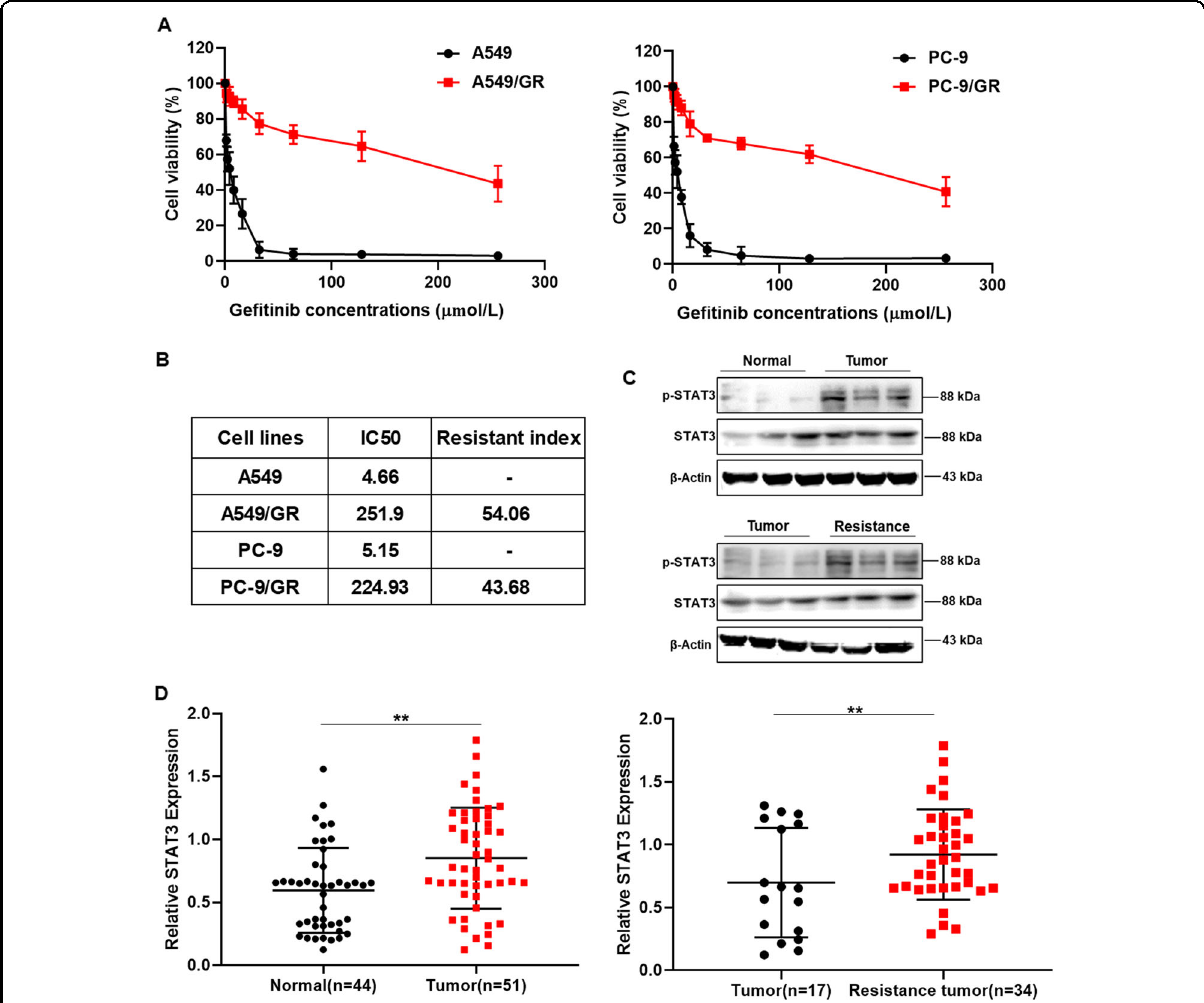
Fig. 1 The expression of p-STAT3 was elevated in ge fi tinib-resistant lung cancer tissues and cells. A A549, A549/GR, PC-9, and PC-9/GR cells were treated with the indicated doses of ge fi tinib for 24 h. Cell viability was determined using the MTT assay. B IC50 and resistance index of lung cancer cell lines. C , D The expression of p-STAT3 in ge fi tinib-resistant lung cancer patients was upregulated. The expression levels of the indicated proteins were examined by Western blot analysis. Data were represented as mean ± SD, n = 3. **p < 0.01, signi fi cantly